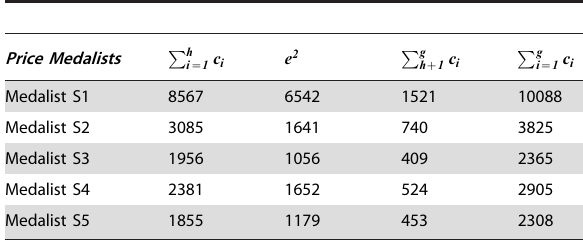
Table 3. The supplemental data in terms of intermediate parameters for the given set of Price